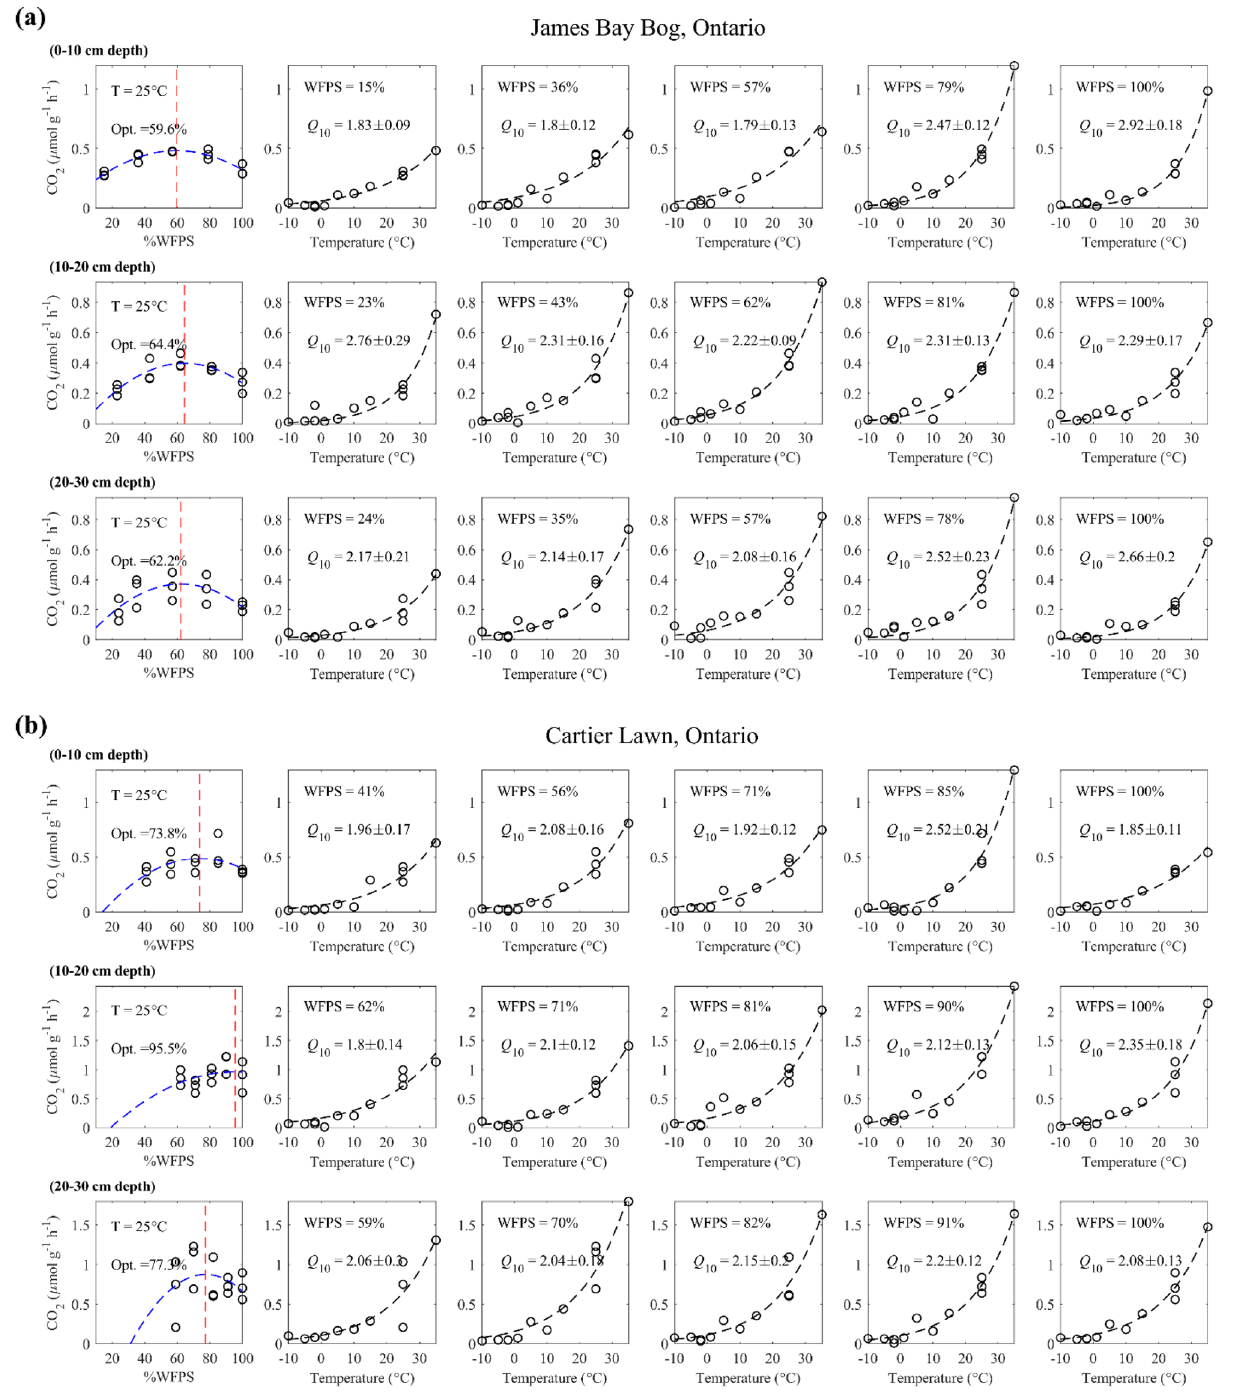
Figure 2. Examples of CO 2 production rates measured for peat samples from one boreal (James Bay Bog, a ) and one temperate site (Cartier Lawn, b ) at different moisture contents (%WFPS; see Table 1). The rates are fitted with Eq. (1) for temperature and Eq. (5) for the moisture dependence. The effect of moisture variation at a fixed incubation temperature (25 °C) is shown in the first leftmost column; the optimum moisture levels for maximum CO 2 production are indicated on the panels. The effects of temperature variations on the CO 2 production at varying peat moisture contents are shown in the next five columns (in increasing order of %WFPS) with the fitted Q 10 values. The results for the other sites are presented in Supplementary Figures S2 to